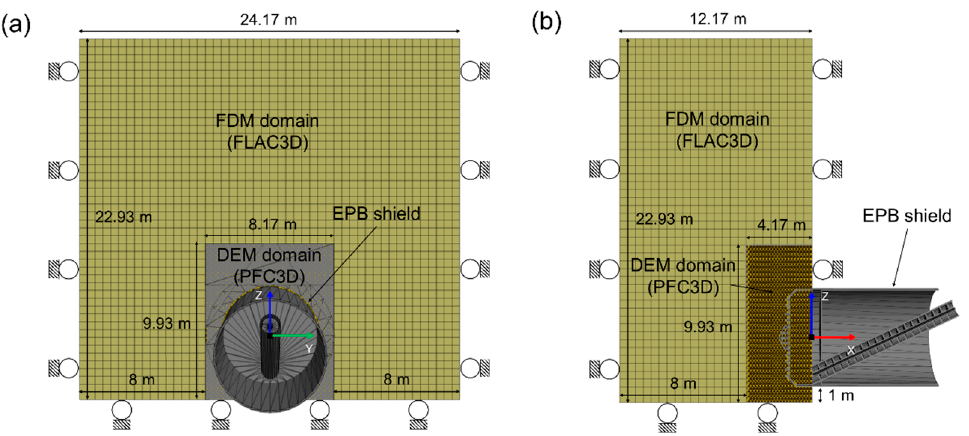
Figure 8. EPB shield tunnelling model using coupled DEM–FDM: ( a ) front view; ( b ) sectional view.